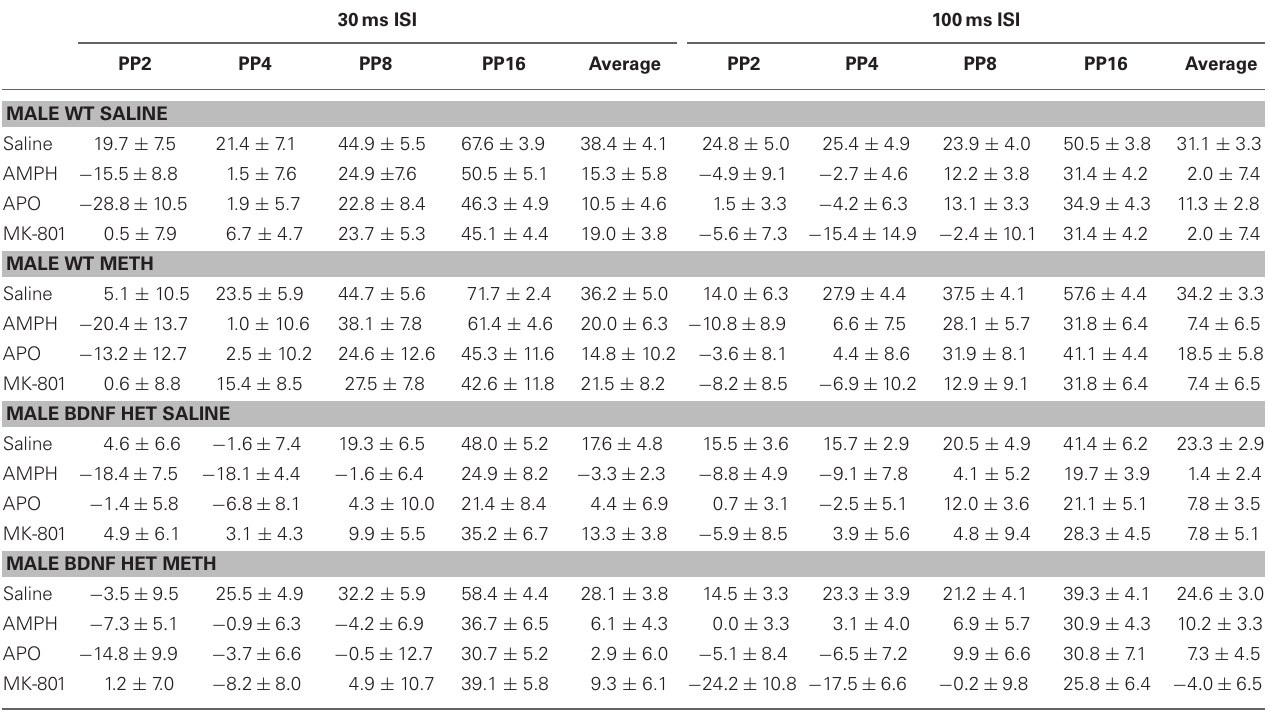
Table 1 | Mean PPI ± SEM at each PP intensity during challenge sessions with saline, AMPH, APO or MK-801 treatment in male WT and BDNF HET mice chronically pre-treated with saline or METH.